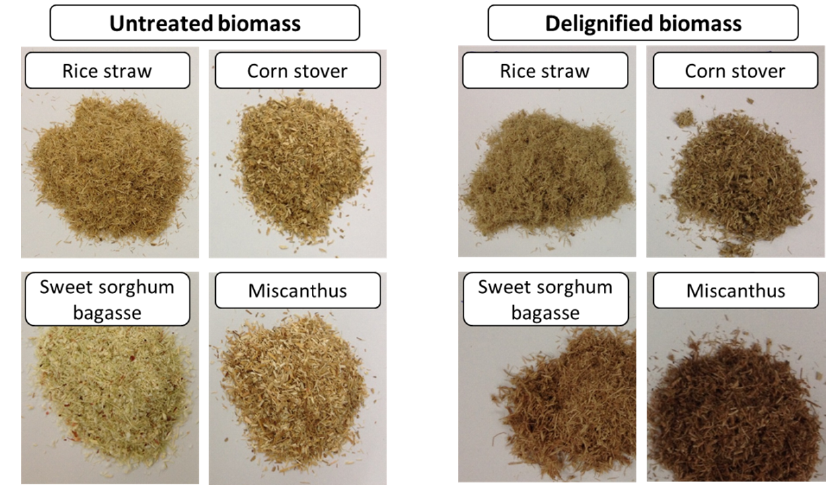
Figure A1. Untreated biomass and delignified biomass.